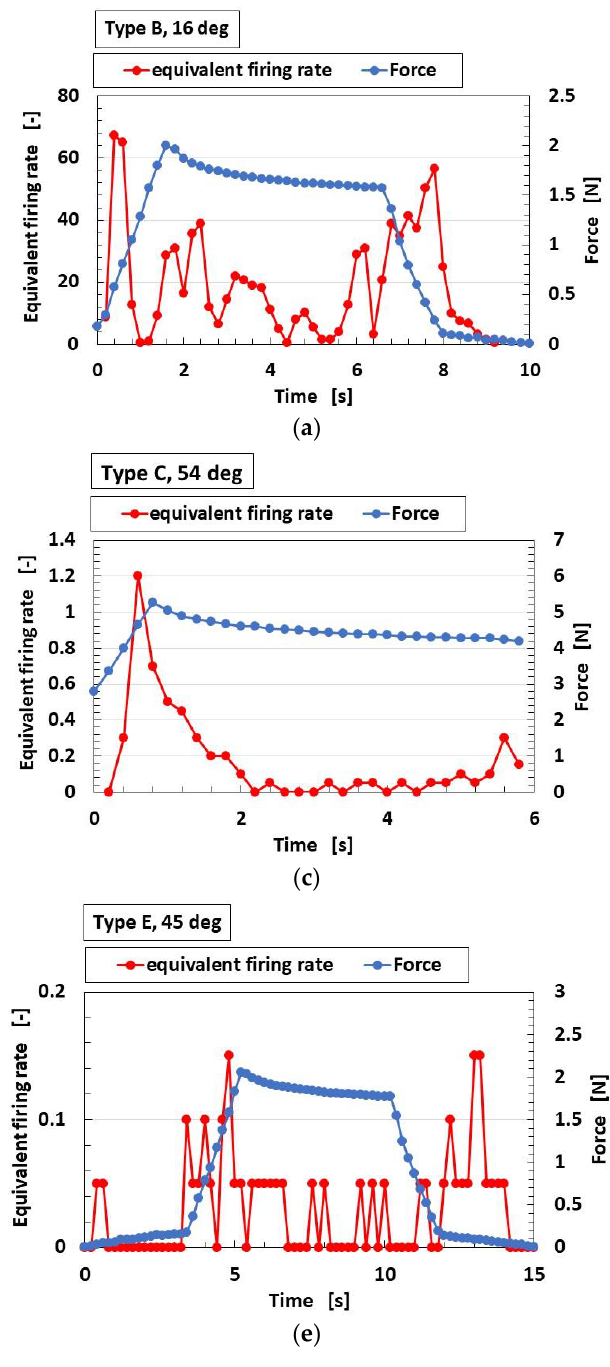
Figure 7. Equivalent firing rate to applied normal force: ( a ) free nerve endings; ( b ) Krause end bulbs; ( c ) Meissner corpuscles; ( d ) Pacinian corpuscles; ( e ) Ruffini endings.